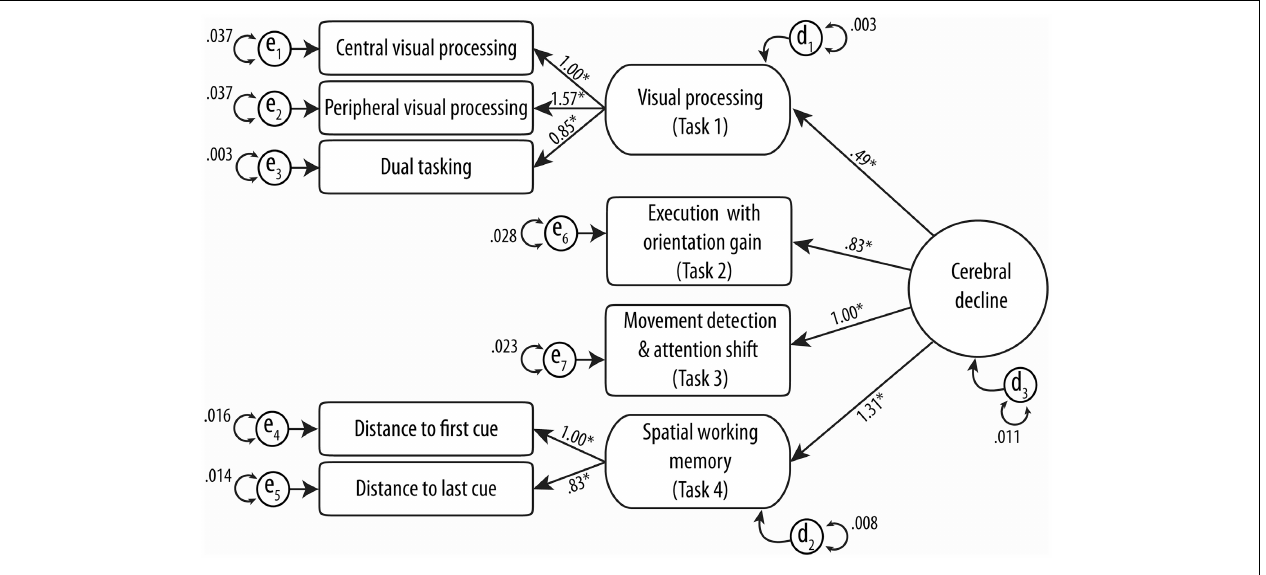
FIGURE 3 | Confirmatory structural equation modeling of MedDrive’s theoretical construct. Circles and rounded-cornered squares represent latent variables. Numbers above straight lines correspond to weights of score for MedDrive outcomes to best